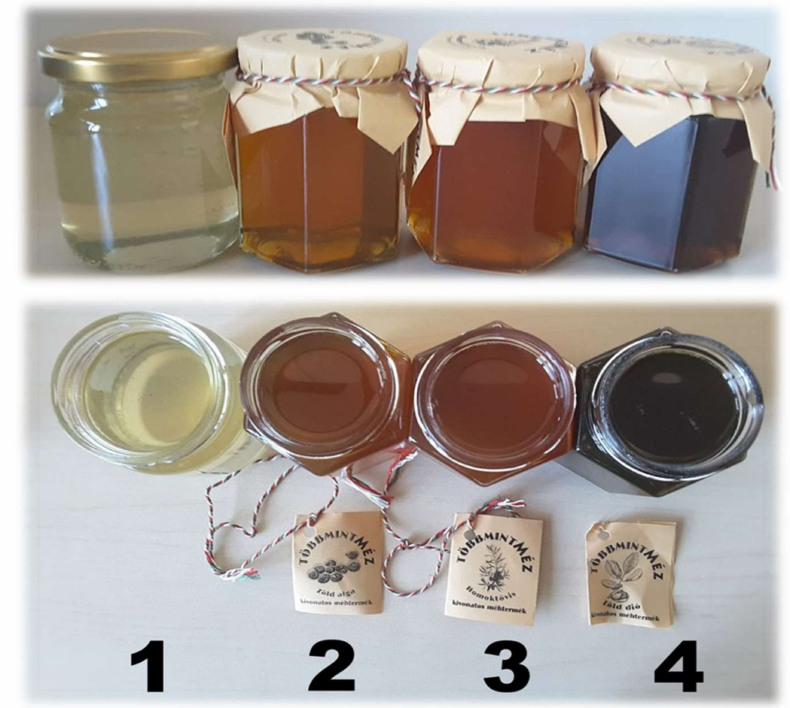
Figure 6. The tested honey in the clinical products belonging to each tested group includes (1) acacia, (2) chlorella alga, (3) sea buckthorn, and (4) green walnut.